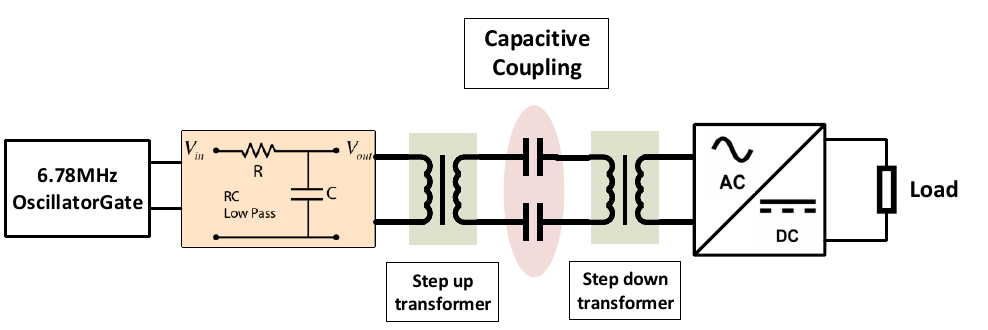
Figure 8. The circuit diagram of 6.78 MHz CCWPT system in